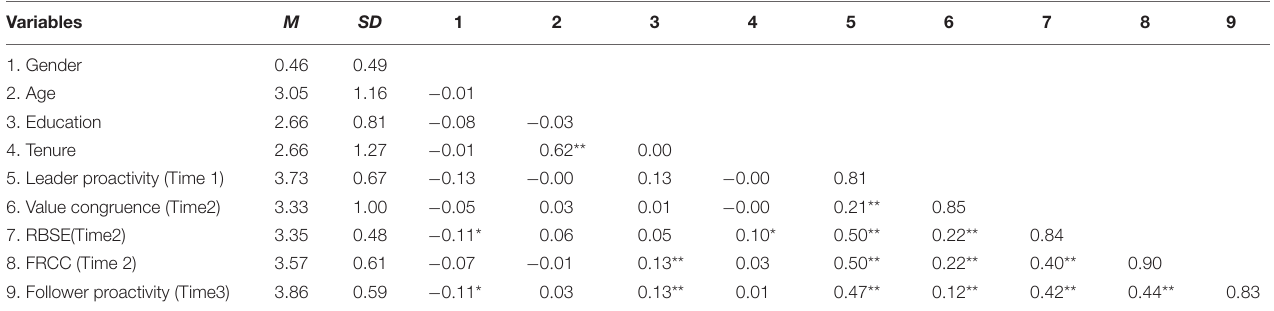
TABLE 4 | Results of descriptive statistical